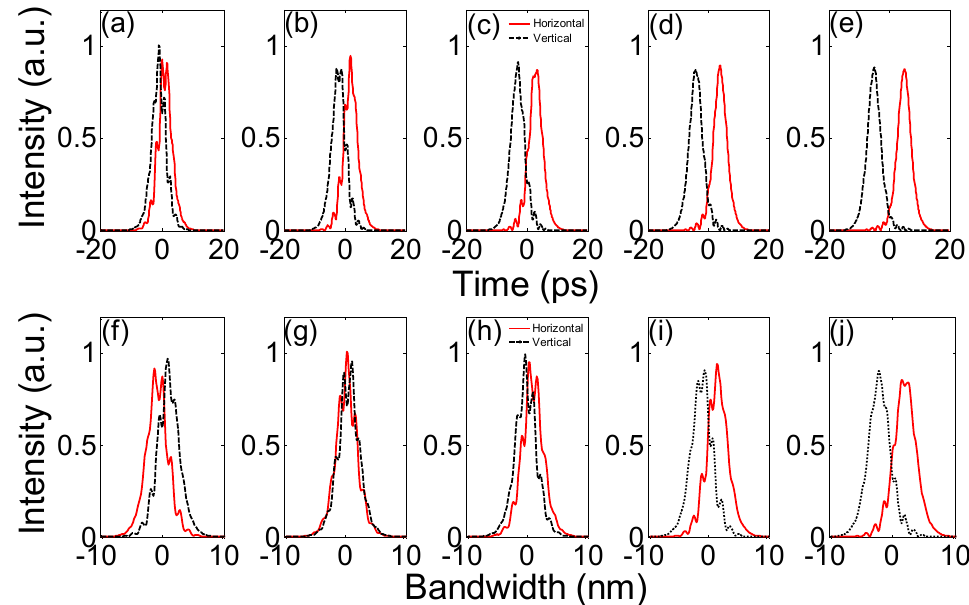
Figure 9. Theoretical results after polarization splitting when the time delay is changed and λ 1 = 1063 nm, λ 2 = 1065 nm.